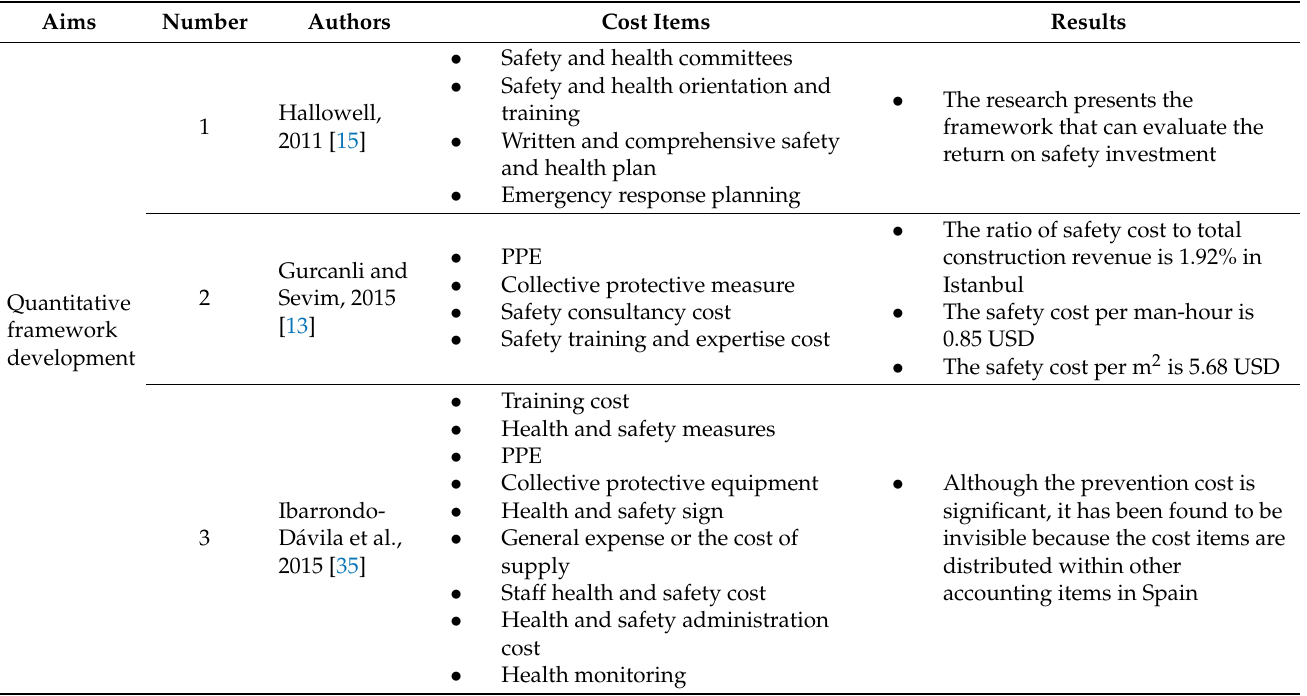
Table 1. Results of literature